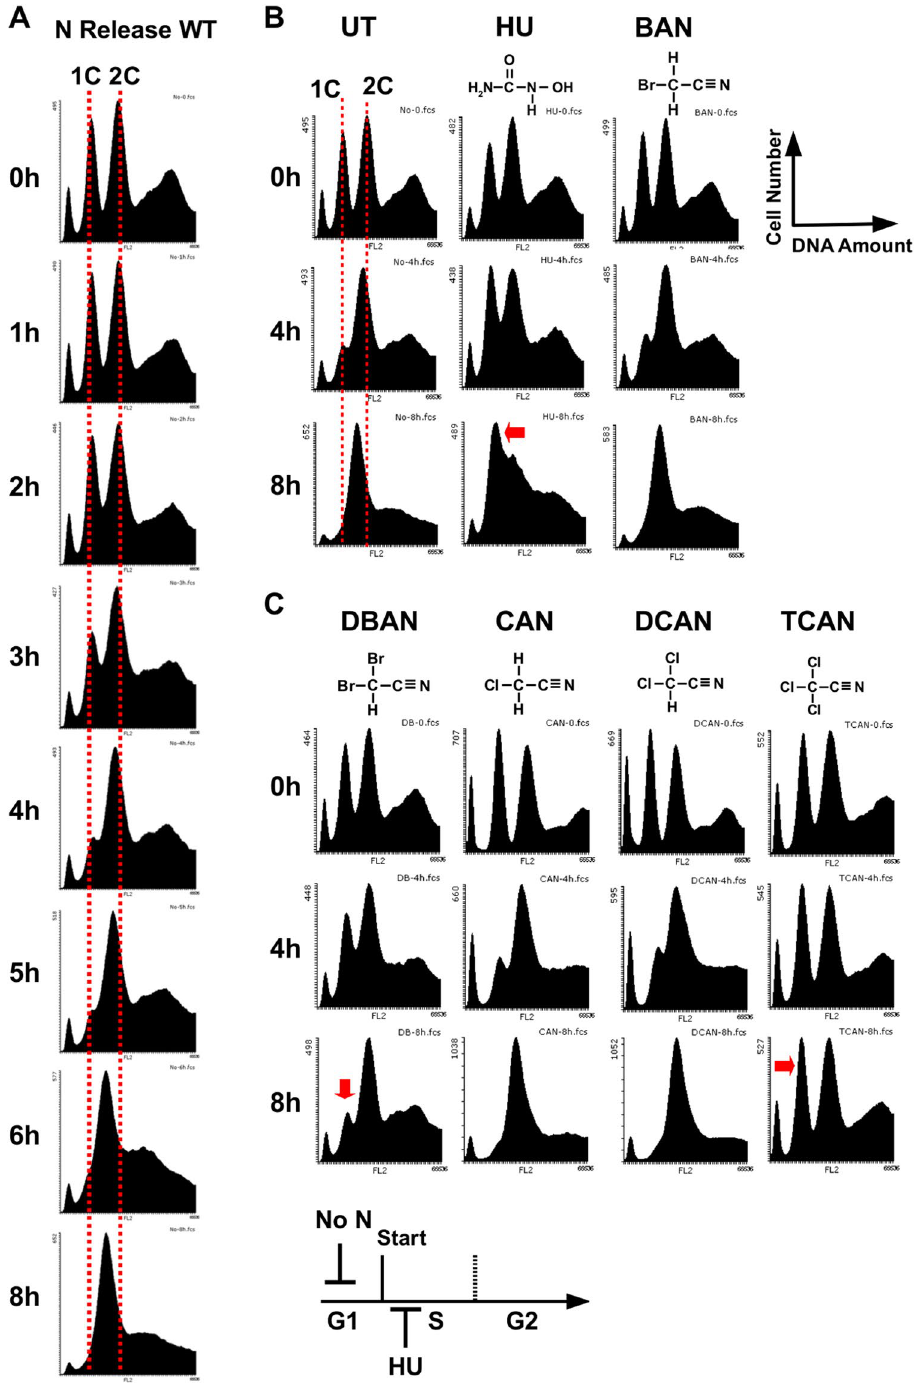
Figure 2. DBAN and TCAN delay G1-S transition. ( A ) Wild type cells without auxotrophic markers were synchronised in G1 by nitrogen starvation in minimal medium (3% glucose, 0.67% nitrogen base w/o amino acids and ammonium sulphate) at 30 °C 29 . Cells were washed and released at T = 0 h into pre-warmed minimal medium with ammonium sulphate. Samples were withdrawn at the indicated time points and the DNA content was measured by flow cytometry 29 . The dotted lines indicate 1 copy of the chromosomes (1 C, G1) and two copies (2 C, G2), respectively. ( B , C ) DNA content at the start of the experiment (0 h), at 4 h and 8 h post-release. Untreated cells (UT) progress from G1 (1 C) to G2 (2 C) within 4 h. This progression is slowed down by DBAN but blocked by TCAN (indicated by the arrows). The final concentration of all HANs is 10 μ M. In a control experiment, cells were arrested in early S (1 C) with 15 mM hydroxyurea